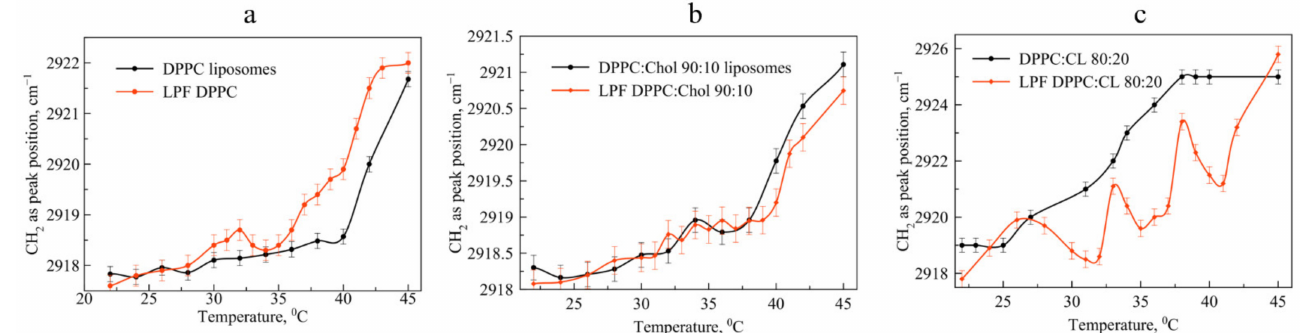
Figure 6. Dependence of wavenumber of ν CH 2 as peak position on the temperature for unloaded liposomes (black line everywhere) and pirfenidone-loaded liposomes (red line everywhere). Subfigure ( a ) represents DPPC 100% lipid composition, ( b ) DPPC:Chol 90:10 and ( c ) DPPC:CL 80:20. For each point SD is presented ( n = 3). Total lipid concentration 5 mg/mL. 0.02 M Na phosphate-buffered solution, pH